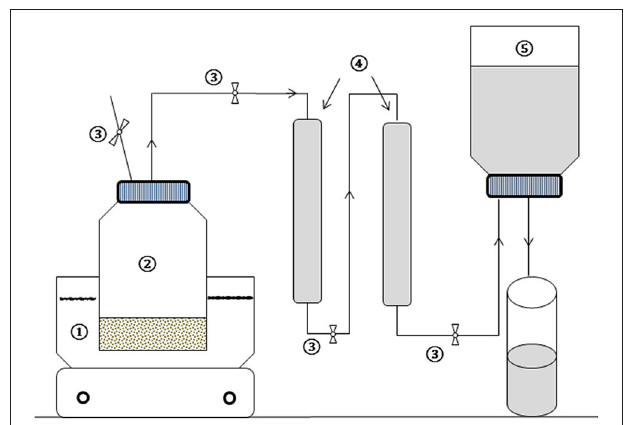
FIGURE 1 | Schematic diagram of the TP experimental set-up: (1) Oil bath heater with stirrer, (2) treatment bottle, (3) controlling valves, (4) trapping columns, and (5) water displacement gas measuring